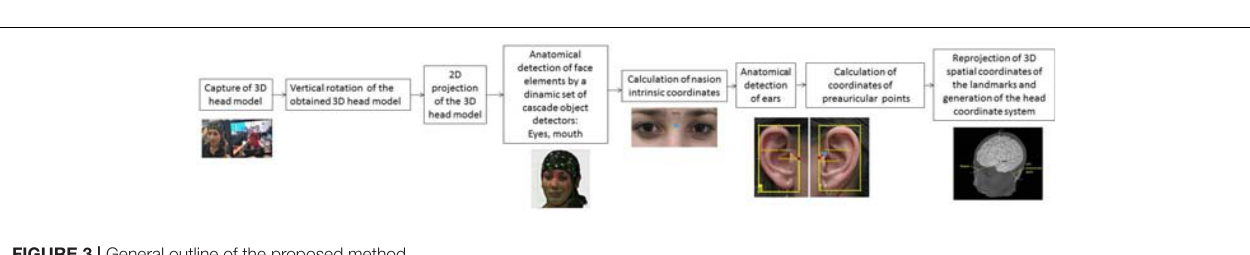
FIGURE 3 | General outline of the proposed